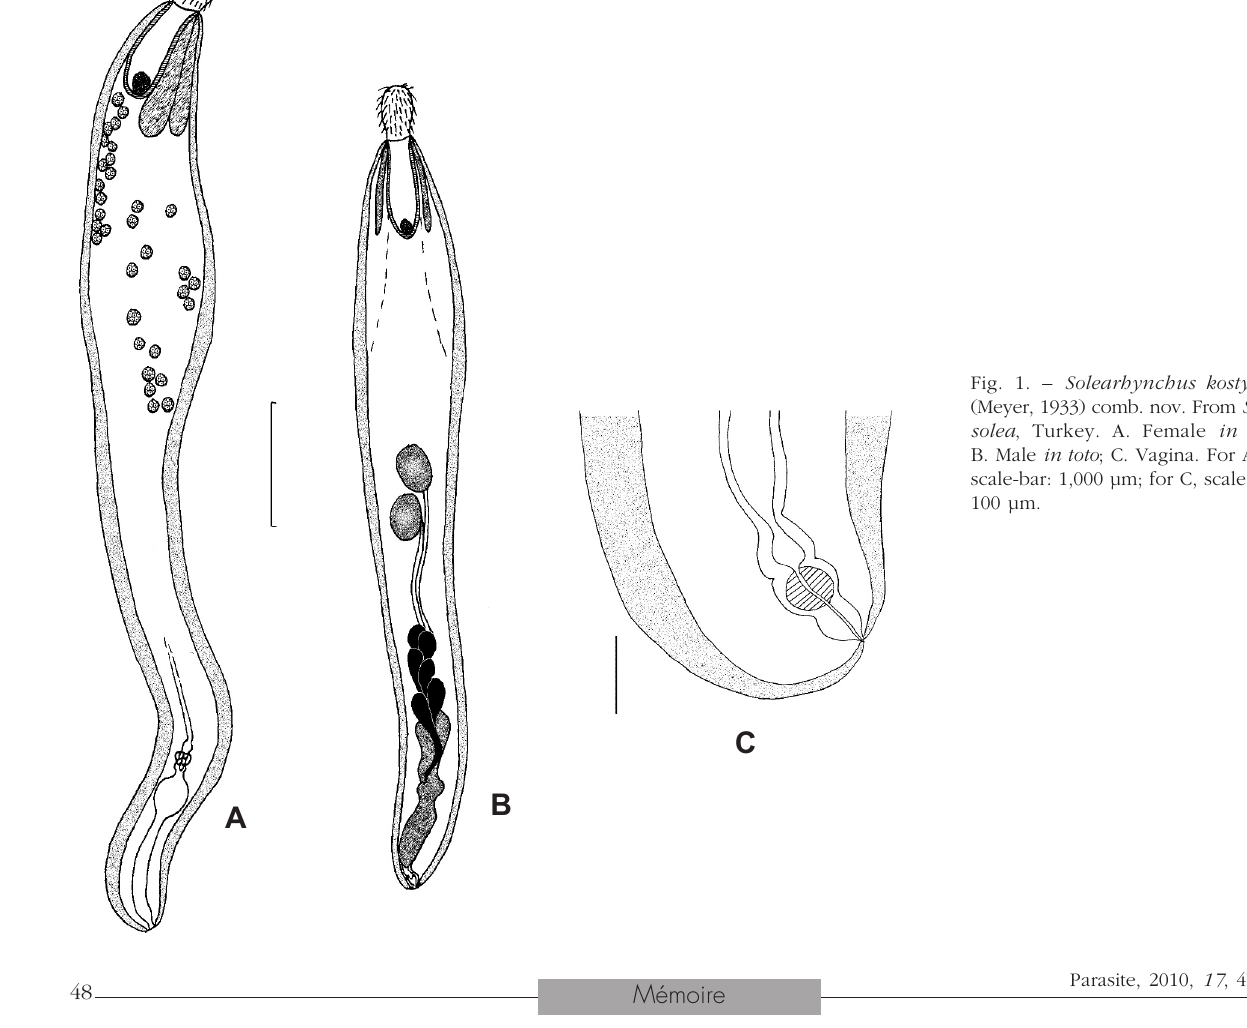
Fig. 1. – Solearhynchus kostylewi (Meyer, 1933) comb. nov. From